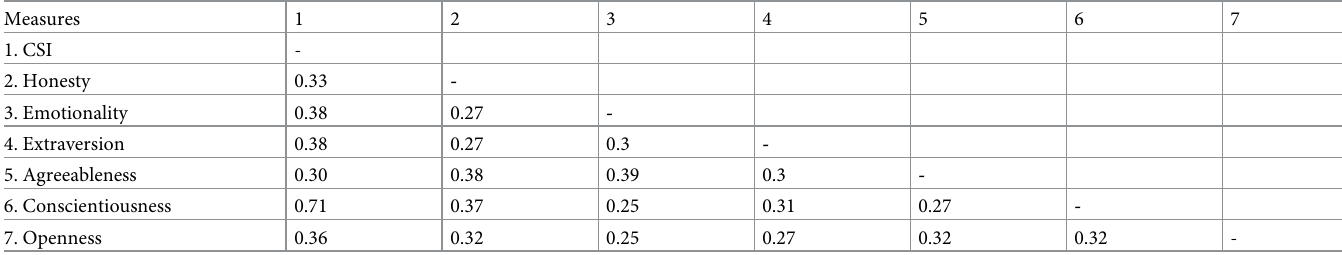
Table 2. The ratios of the CSI with the HEXACO-PI-R resulting from the HTMT method.